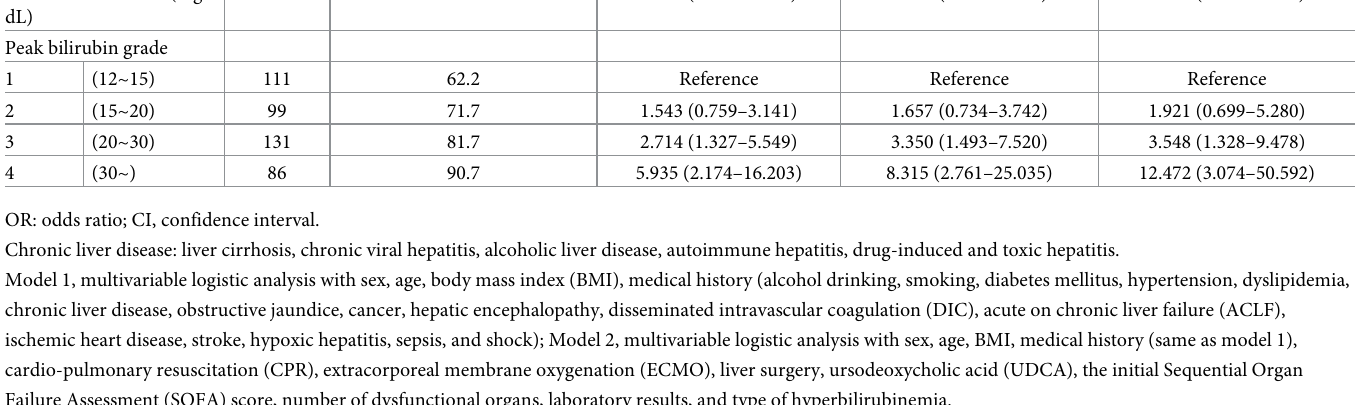
obstructive jaundice was higher in the direct than the indirect hyperbilirubinemia patients